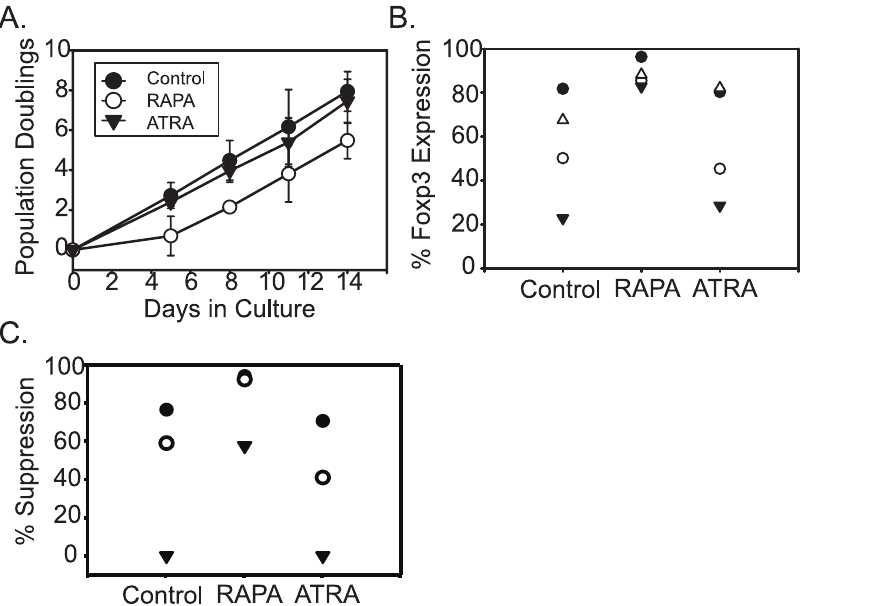
Figure 3. Treg expansion performed in the absence of serum results in more durable Treg suppressive activity. A . Enriched Tregs were expanded in the absence of human serum. Where indicated, 10 nM ATRA or 100 ng/ml RAPA were added to the medium and this concentration of drug was added to media used to feed the cultures. Cell counting was performed on the indicated days. The data reflects the average of 3 cultures using enriched Tregs from different healthy donors. Error bars represent the standard deviation. ( B .) At the end of culture, FOXP3 expression was measured by flow cytometry, and ( C .) an in vitro suppressive assay was performed. For parts B. and C., each symbol refers to data collected from a single donor.